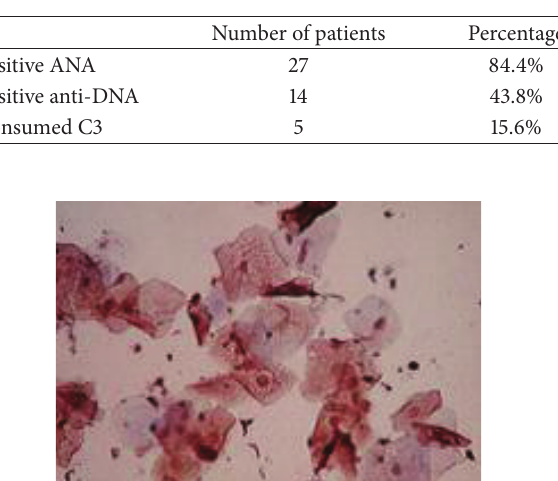
Table 3: Showing autoimmune profile and complement.